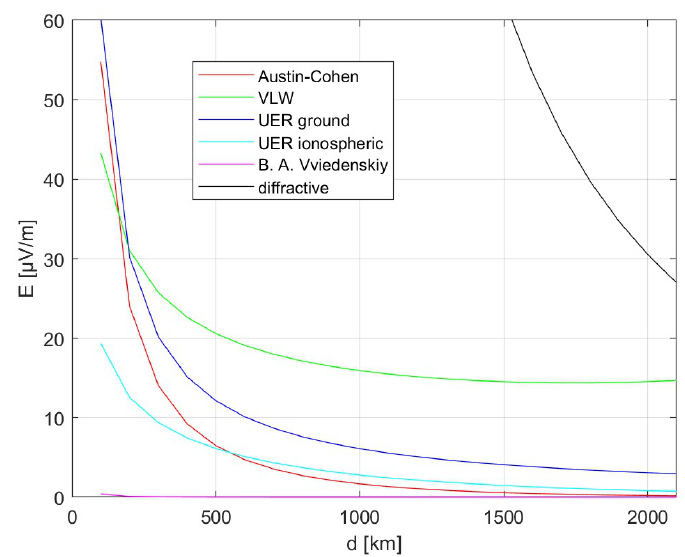
Figure 14. The E field strength (RMS) calculated for IGLUNA 2019 LW experiment using different formulas.